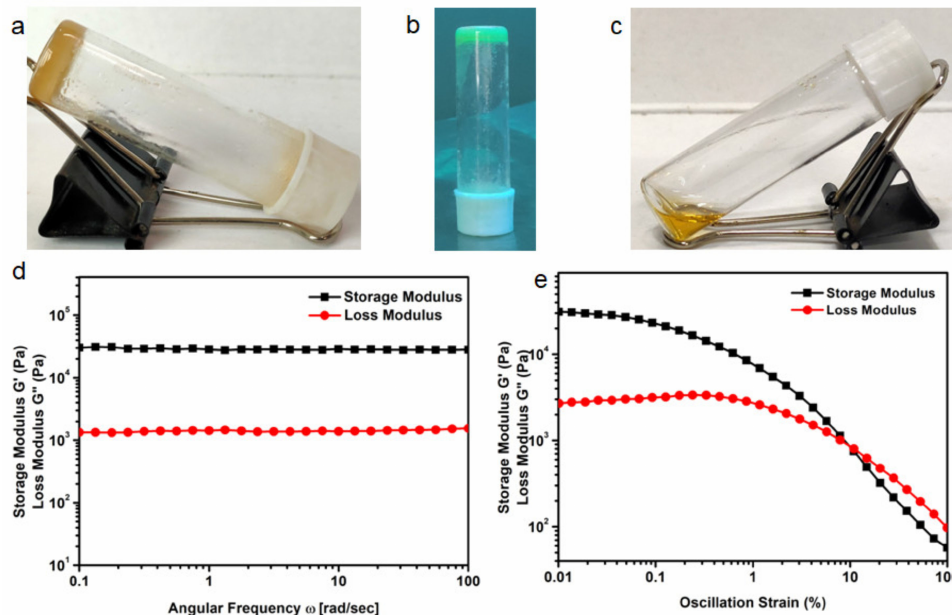
Figure 2. ( a ) The image showing NDI 1 and β -CD gel in DMF; ( b ) The NDI 1 and β -CD gel in DMF under 254 nm light showing blue-green emission; ( c ) The image showing NDI 2 and β -CD failed to form a gel in DMF; ( d ) Effect of angular frequency on NDI 1 and β -CD gel in DMF at 25 ◦ C; ( e ) Effect of strain on NDI 1 and β -CD gel in DMF at 25 ◦